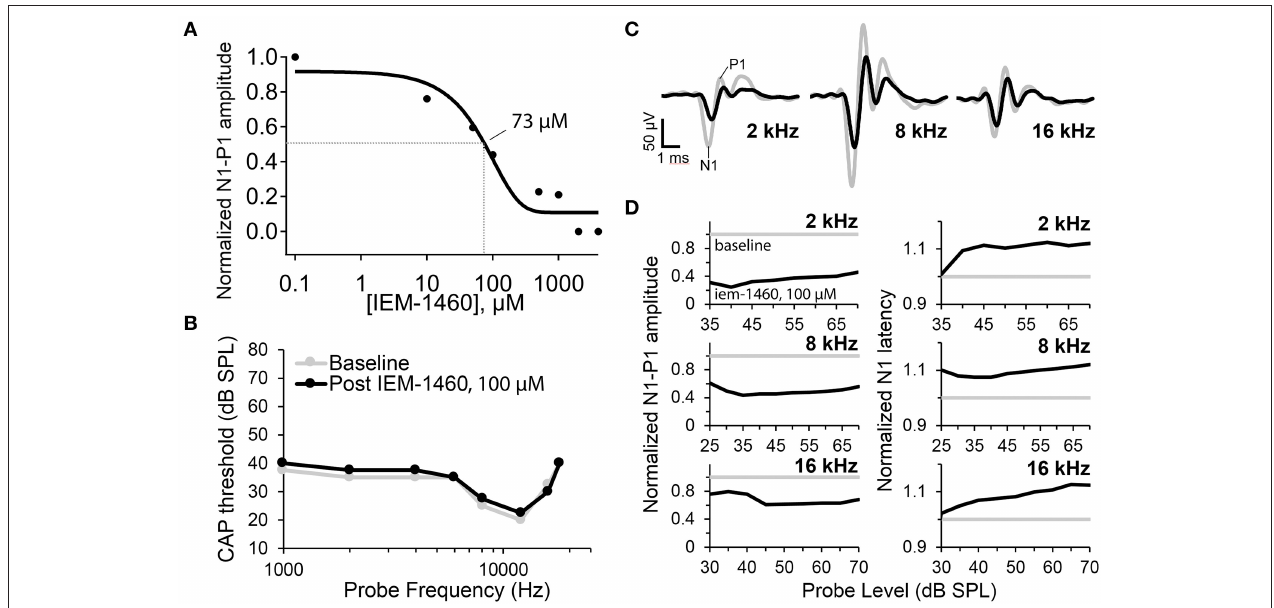
FIGURE 4 | Auditory nerve compound action potential (CAP) measurements before and after cochlear perfusion with IEM-1460. (A) IEM-1460 dose-response inhibition curve shows relative reduction in CAP amplitude with increasing concentration of IEM-1460 varying from 0.1 to 4,000 µ M ( N = 6 female guinea pigs, 8–9-weeks-old). Probe level was 80 dB SPL. Fractional reduction from baseline was averaged for responses to 2 and 16kHz tones. IC 50 = ∼ 73 µ M. (B) CAP thresholds across frequencies before and after perfusion of 100 µ M IEM-1460 in artificial perilymph into scala tympani from an injection pipette sealed to the cochlear apex. C) CAP waveforms in response to 70 dB SPL tone bursts at 2, 8, and 16kHz. Gray traces were recorded before perfusion, and black traces were recorded after perfusion of 100 µ M IEM-1460 in artificial perilymph. (D) Baseline normalized CAP amplitudes (N1-P1, left) and N1 latencies (right) as a function of probe level